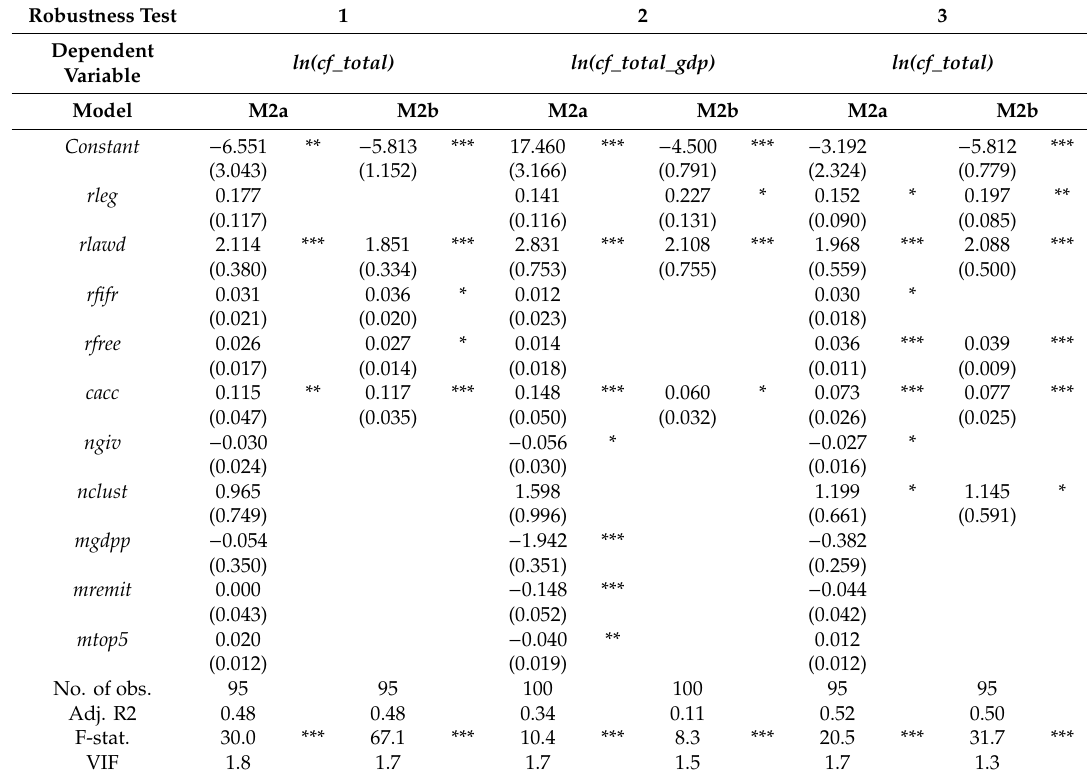
Table A5. Robustness of Institutional Determinants of Total Crowdfunding Volumes during 2015–2016 per